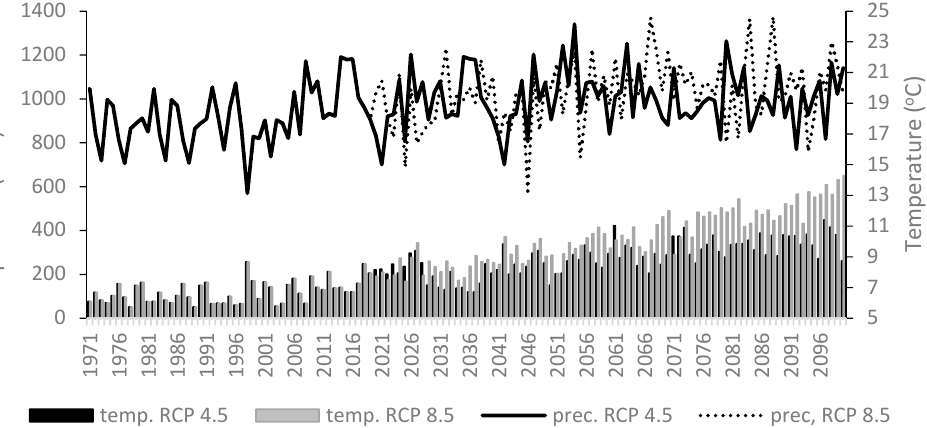
Table 4. Soil organic carbon (SOC) stock (Mg ha − 1 ) over 21st century under corn–corn–soybean–winter wheat # (CCSW), switchgrass and miscanthus.